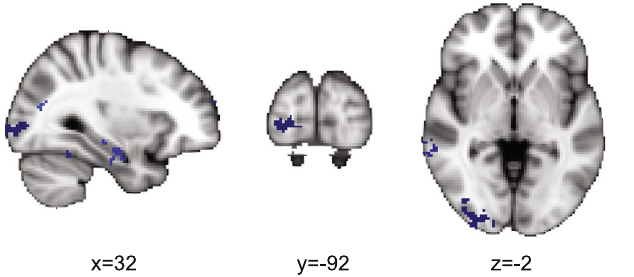
Figure 5. Sagittal, coronal, and axial slices in MNI space of the posterior cluster extending from the right LOC to the right occipital pole at a significance threshold of p corrected < 0.05.